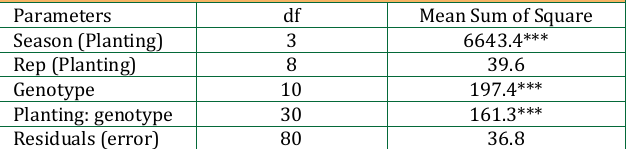
Table 2: Mean squares of combined analysis of variance of marketable tuber yield(tha -1 ) of 11 genotypes evaluated across